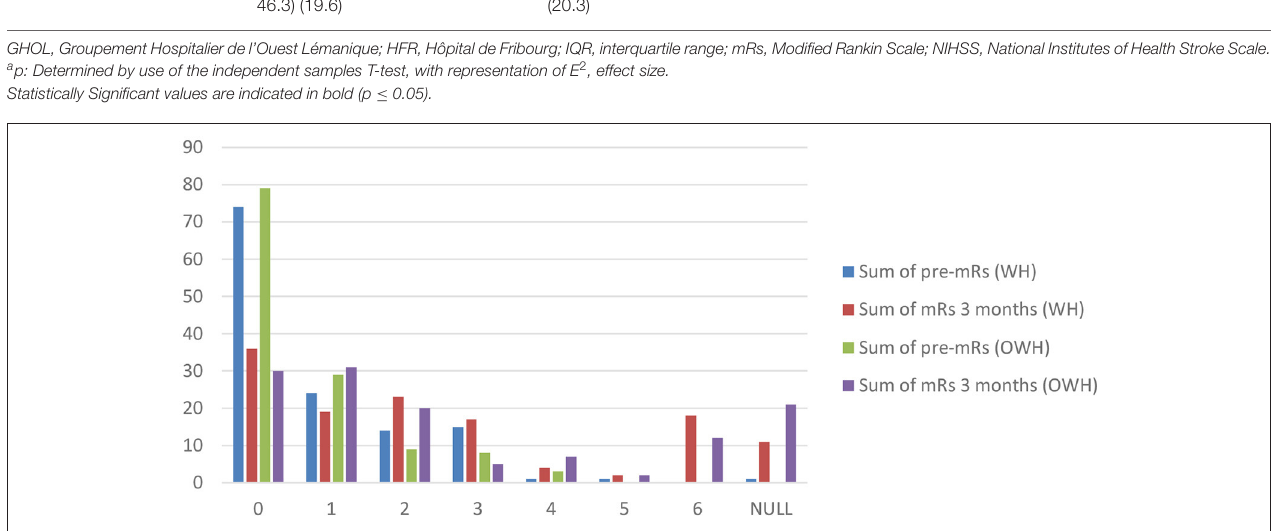
FIGURE 1 | Pre-mRs compared with post-mRs evaluated 90 days following acute ischemic stroke according to admission time. mRs, Modified Rankin